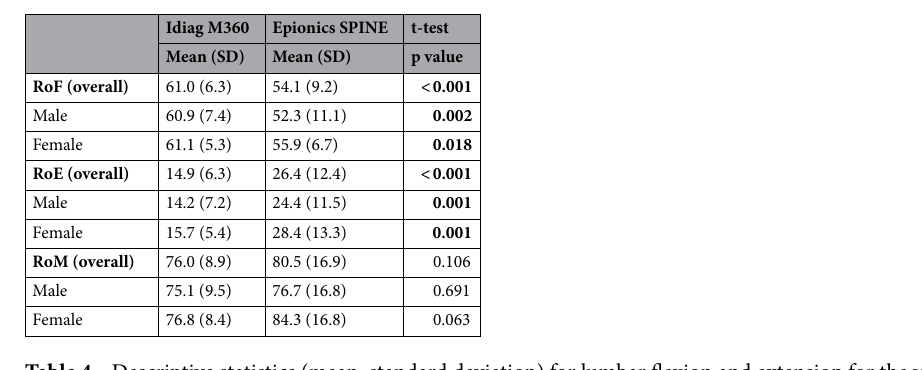
Table 4. Descriptive statistics (mean, standard deviation) for lumbar flexion and extension for the whole study population (overall) as well as males and females separately for Idiag M360 and Epionics SPINE. p values base on paired